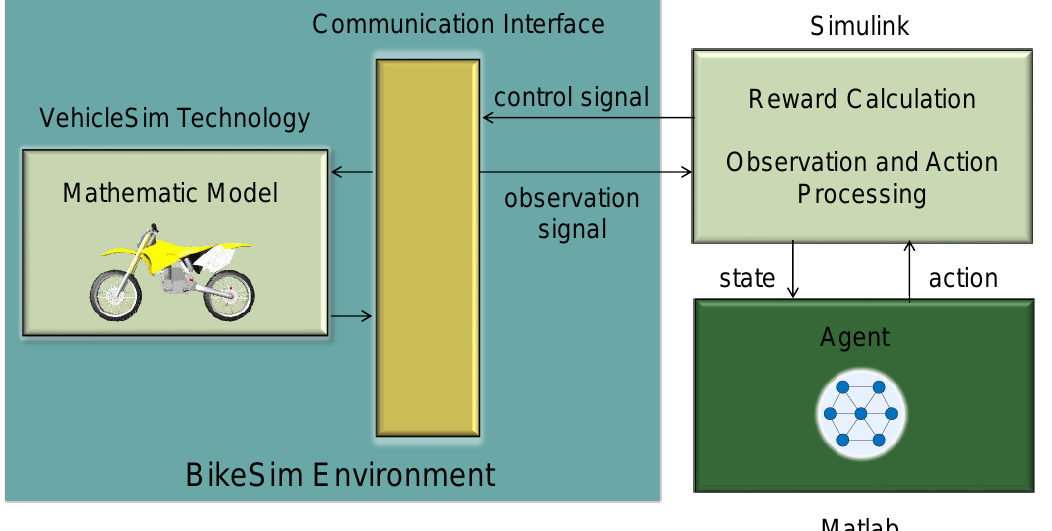
Figure 6. Simulation platform.